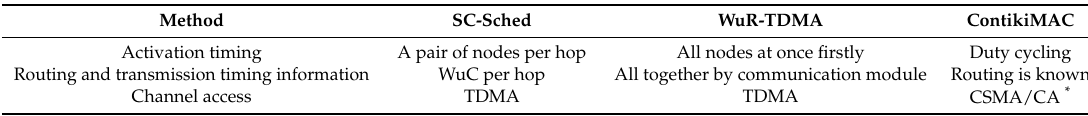
Table 1. Comparison of different